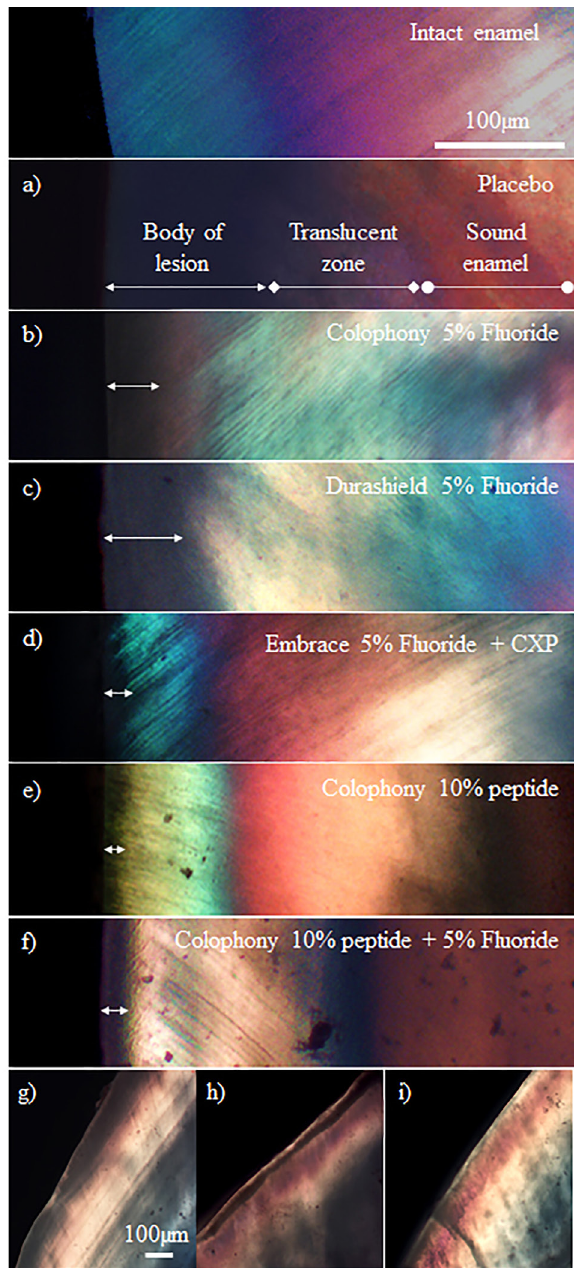
Figure 3- (a-f) Representative PLM images used for measuring the lesion depth decrease (g-i): Representative PLM images of subsurface demineralized regions